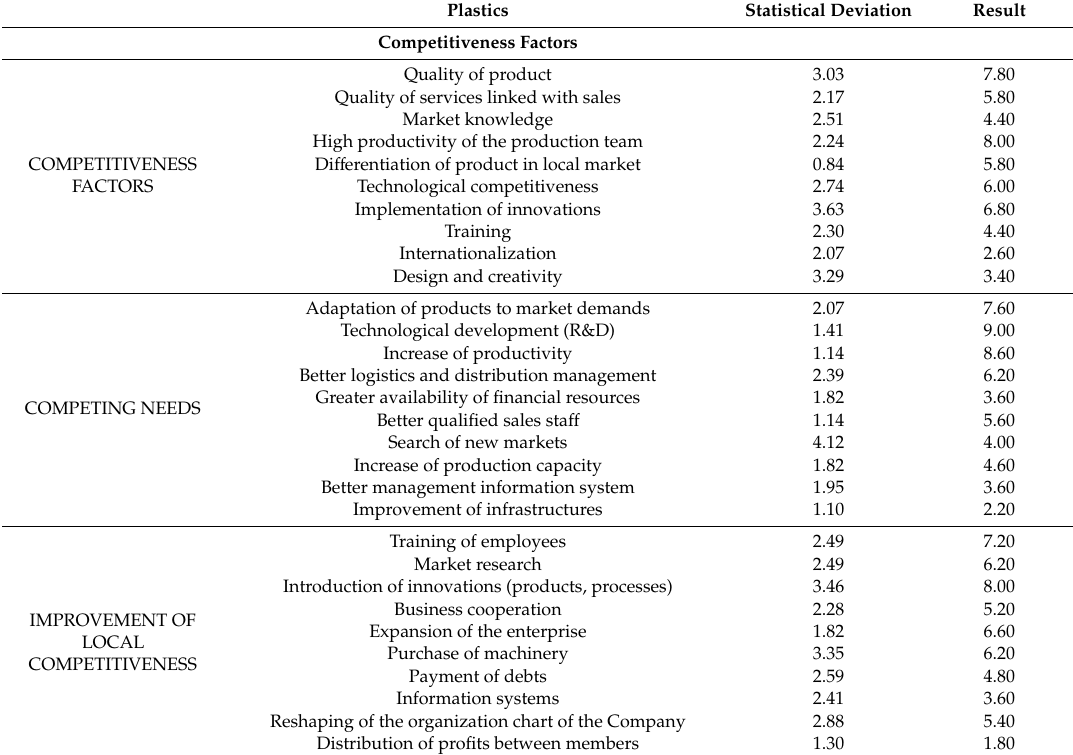
Table A3. Results and Statistical Deviation: Machinery: